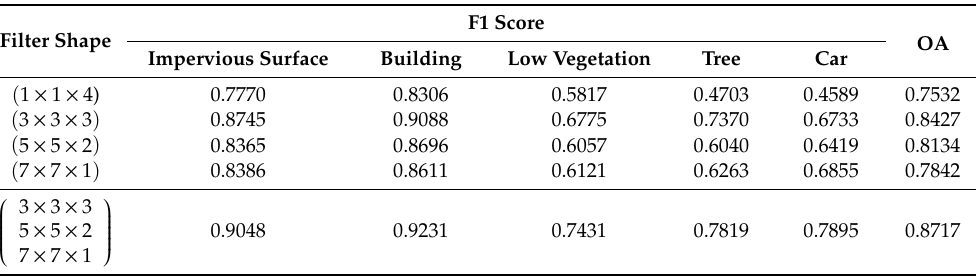
Table 2. Classification results for validating the ISPRS Potsdam dataset using the fully convolutional network (FCN) with di ff erently-sized 3D filters. “OA” represents overall